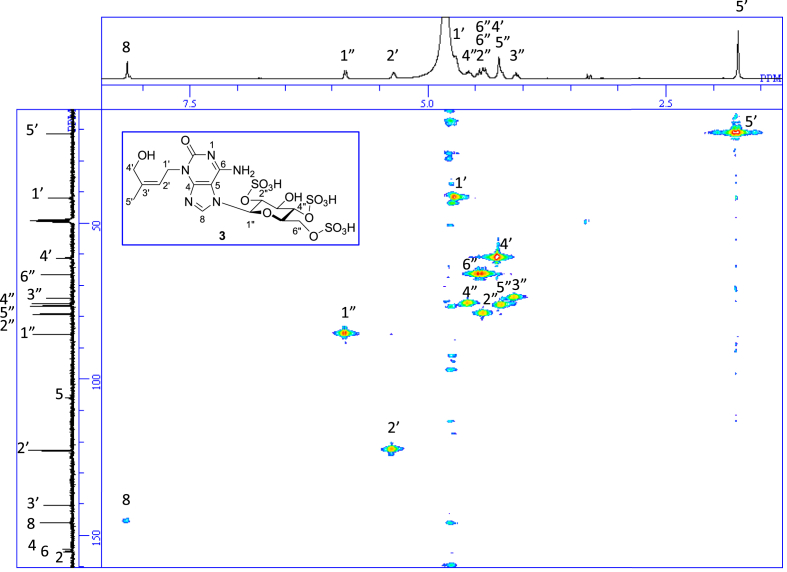
1H–13C HSQC of 3.